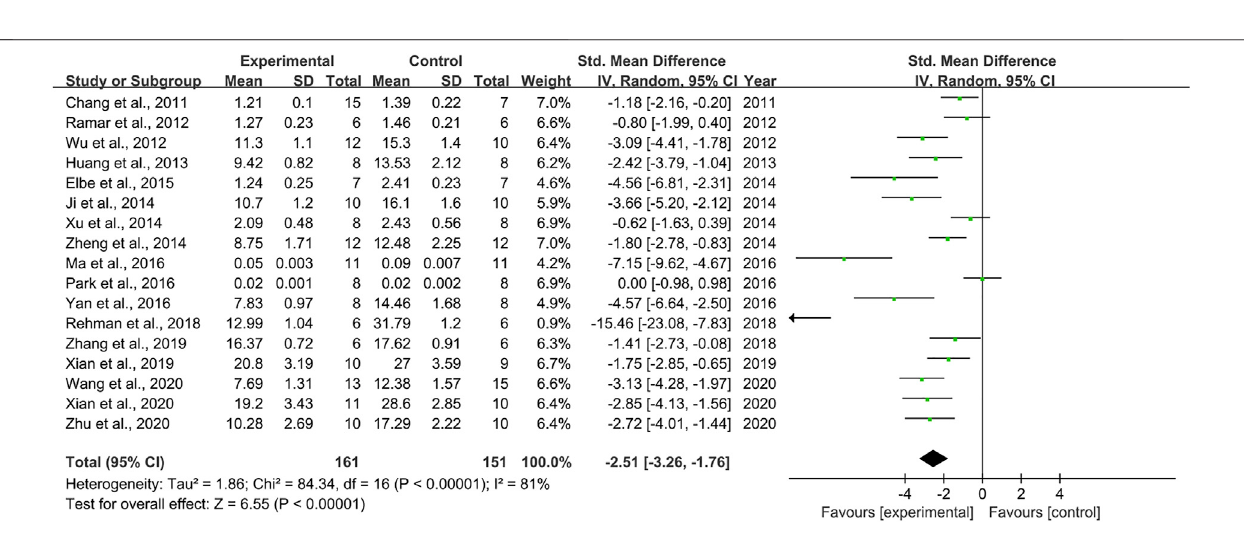
FIGURE 4 | Pooled estimate of BUN with